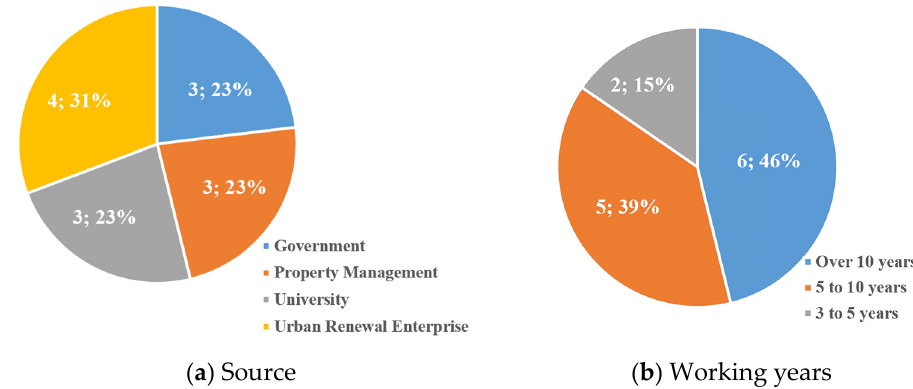
Figure 4. Information regarding the experts.